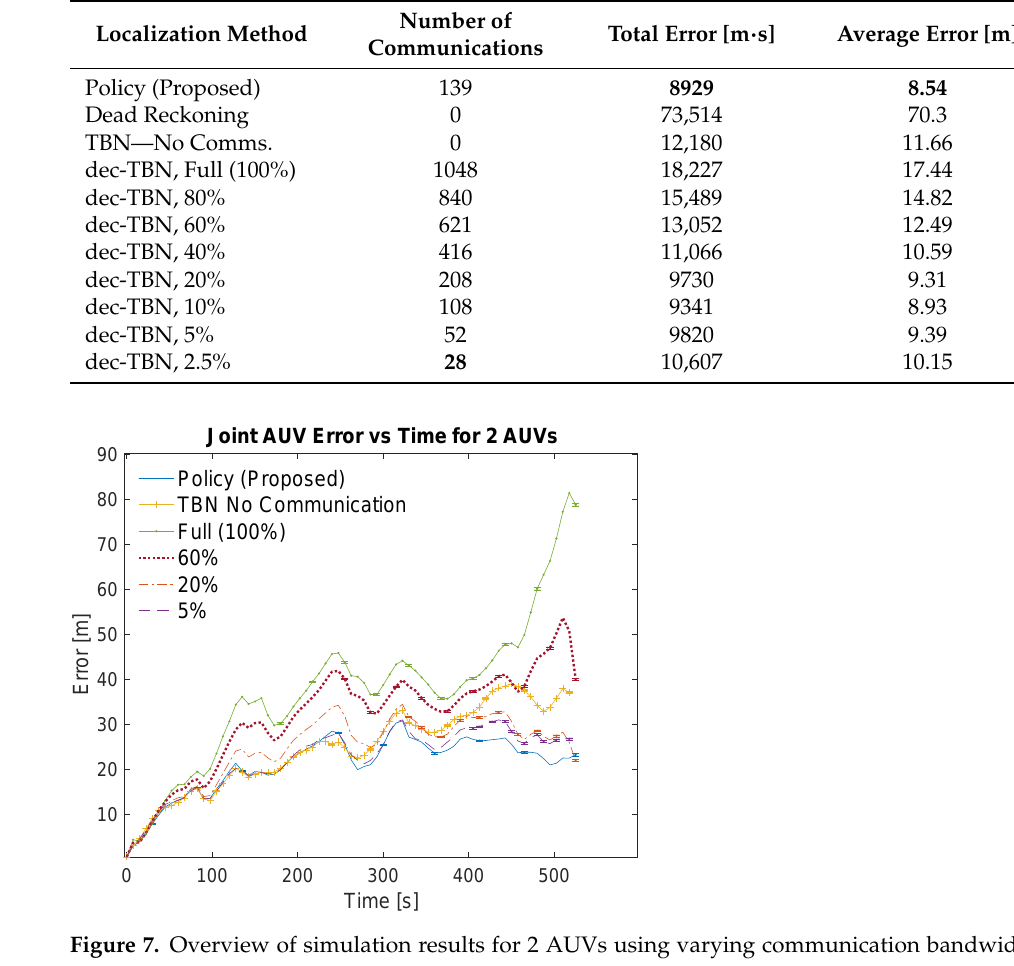
Table 4. Localization methods, communication bandwidth and total joint error for 4 AUVs over the course of a 1.5 km track.